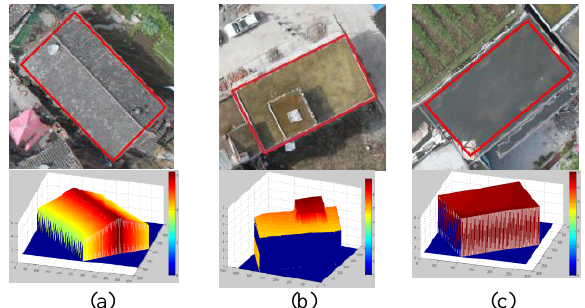
Figure 8. Types of buildings in Ya’an earthquake and Wenchuan earthquake: (a) herringbone type; (b) convex